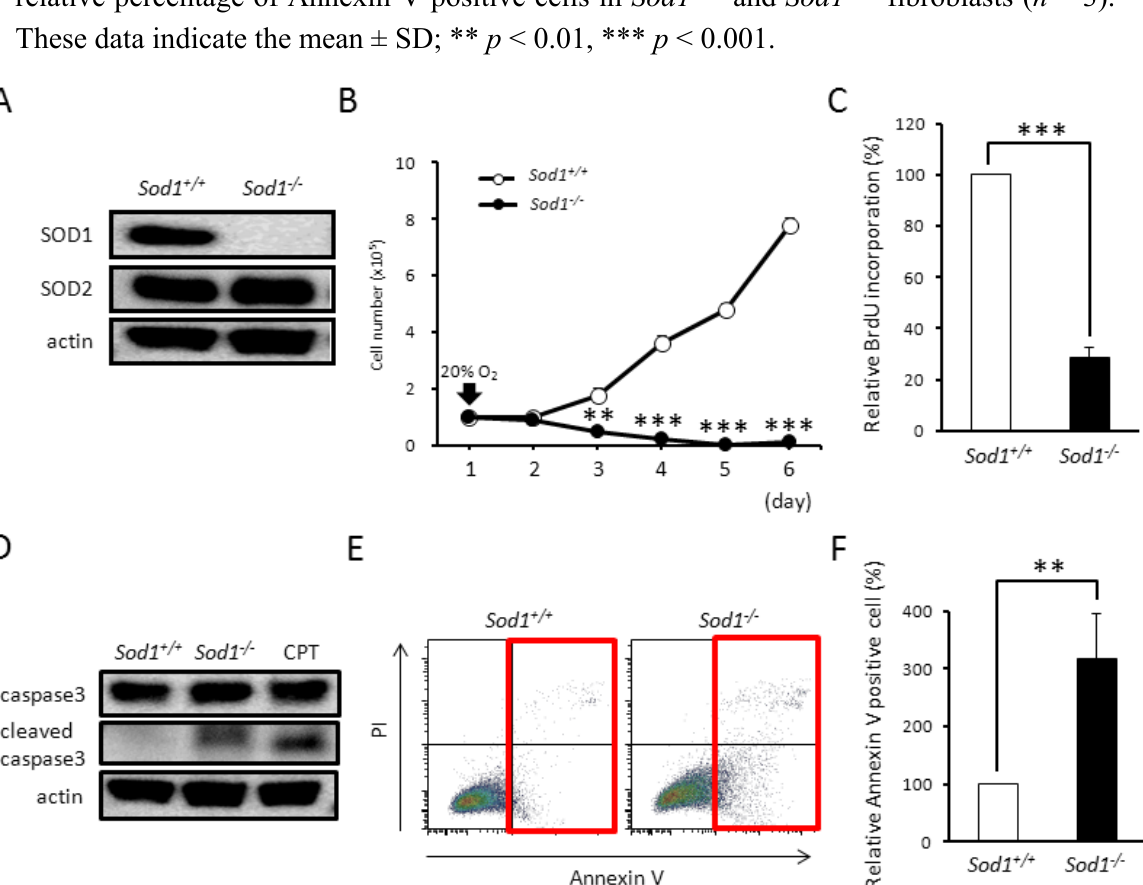
fibroblasts. ( A ) SOD1 and SOD2 expression in Sod1 − / − and Sod1 +/+ fibroblast. ( B ) The cell numbers of Sod1 − / − and Sod1 +/+ fibroblasts ( n = 3) were counted at the times indicated; ( C ) The cell viabilities of Sod1 − / − and Sod1 +/+ fibroblasts ( n = 3) were measured by BrdU incorporation; ( D ) Apoptosis in Sod1 − / − and Sod1 +/+ fibroblasts was analyzed by western blotting with an anti-cleaved caspase3 antibody. To induce apoptosis, the cells were